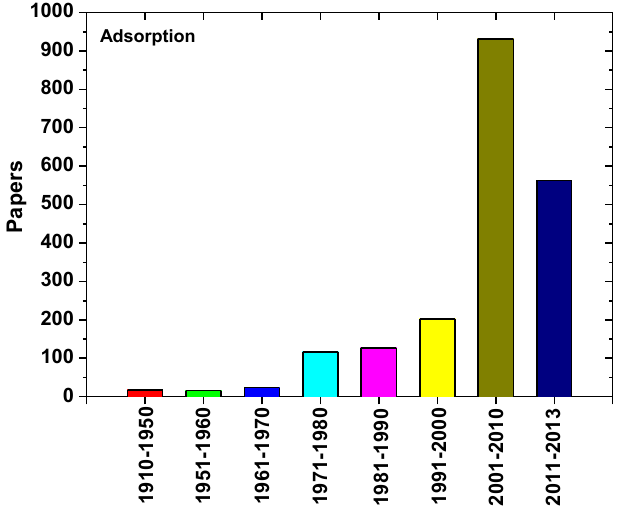
Figure 1. Works published for “dye adsorption” terms (Data after search in